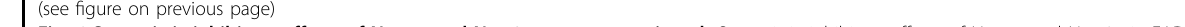
Fig. 6 Synergistic inhibitory effects of Nec-1s and Nec-34 on necroptosis. a , b Synergistic inhibitory effects of Nec-1s and Nec-34 in FADD- de fi cient Jurkat cells ( a ) and L929 cells ( b ). Cells were pretreated with different concentrations of Nec-1s, Nec-34, or Nec-1s/Nec-34 at a constant ratio 1:1 (e.g., 10 μ M Nec-1s alone, 10 μ M Nec-34 alone or 5 μ M + 5 μ M Nec-1s/Nec-34) for 30 min, and then TNF α , TNF α /SM-164 or TNF α /5Z7 were added for an additional 8 h. c The combination indexes calculated from a and b . d The Tm values of recombinant hRIPK1 in compounds-treated groups were compared to that of the control group and presented as Δ Tm for protein thermal shift assay. The recombinant protein hRIPK1 (residues 1 – 330, 2 μ M) puri fi ed from Sf-9 cells was treated with 80 μ M Nec-1s, 80 μ M Nec-4 and 80 μ M Nec-34 alone or with combined Nec-1s/Nec-4 (40 μ M + 40 μ M) and Nec-1s/Nec-34 (40 μ M + 40 μ M) for 1 h, protein thermal stability was then analyzed through the differential scanning calorimetry by real-time PCR and the Tm values were calculated by Protein Thermal Shift Software. Three replicates for each reaction were performed. e , f Synergistic inhibitory effects of Nec-1s and Nec-34 in TNF α -induced SIRS model. Six-week-old C57BL/6J male mice were pretreated intragastrically with Nec-1s (2 mg/kg, n = 7), ( R )-484 (2 mg/kg, n = 7) or combination of Nec-1s and ( R )-484 (1 mg/kg + 1 mg/kg, n = 7) for 15 min, and then